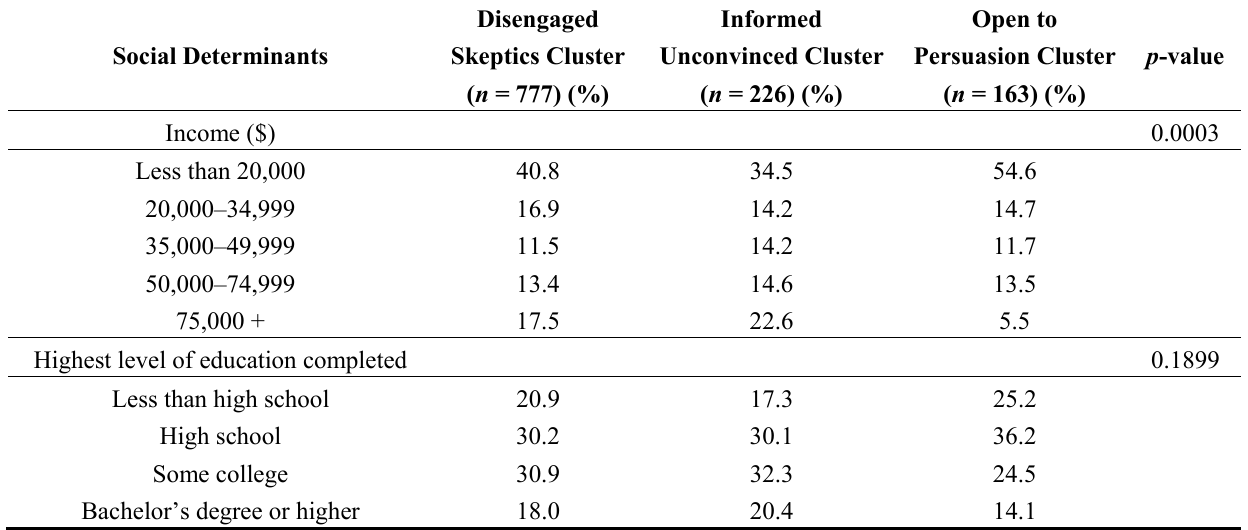
Table 5. Pattern of social determinants between three cluster groups ( n =